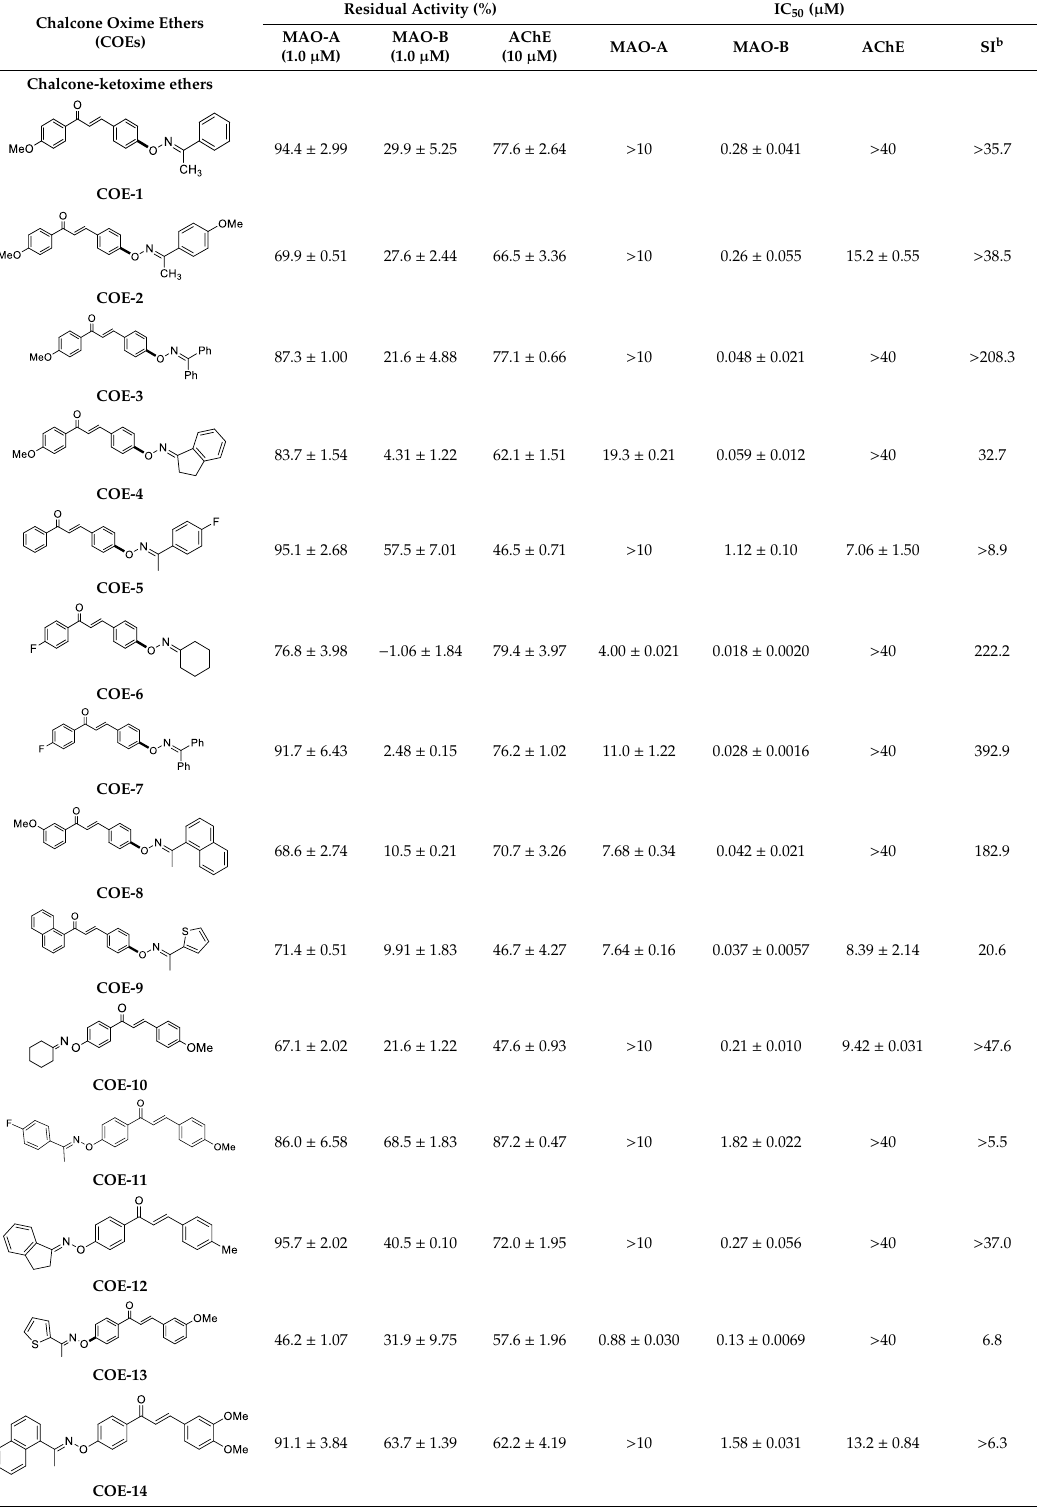
Table 1. Inhibitions of recombinant human MAO-A, MAO-B, and AChE by chalcone oxime ethers a .